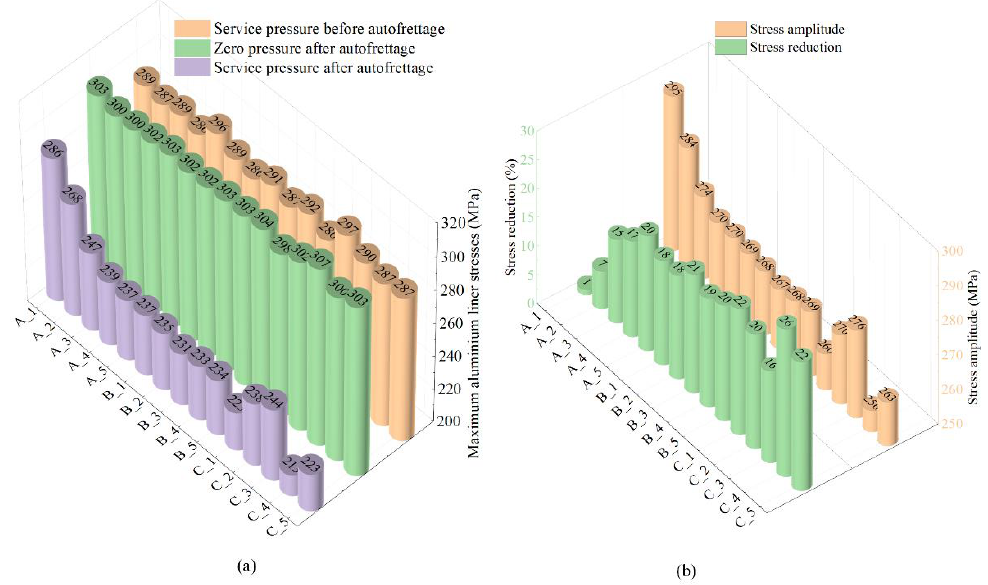
Figure 17. Numerical results of the maximum stress of the aluminum liner: ( a ) under different pressure; ( b ) stress reduction and stress amplitude.